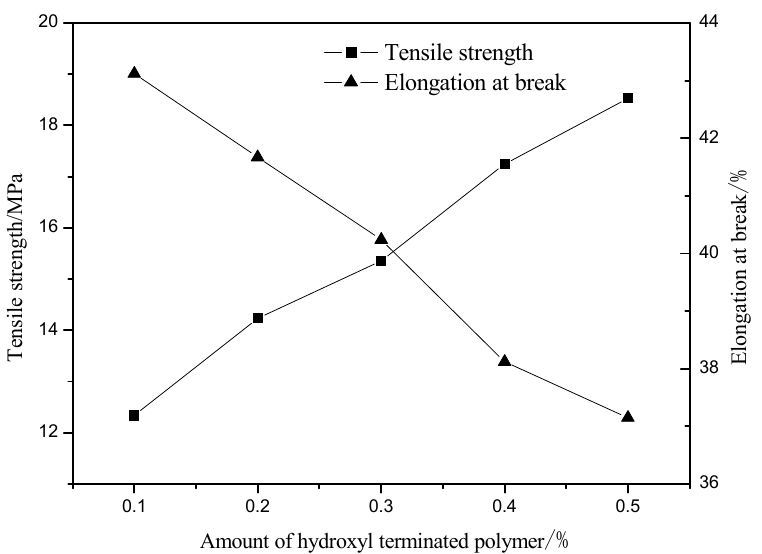
Figure 10. Effect of the amount of hydroxyl terminated polymer on elongation at break strength grade.